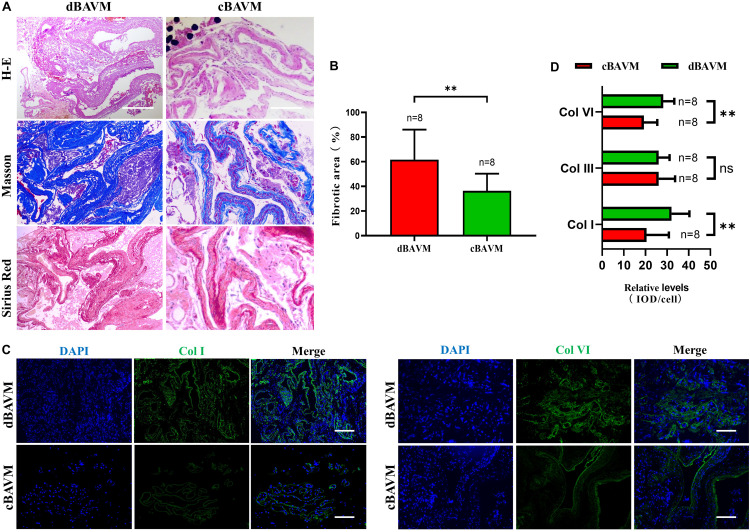
Upregulation of DCN promotes the overproduction of extracellular matrix in diffuse BAVMs. (A) Masson and Sirius red staining for collagen deposition in BAVM tissues. Fibronectin and collagen area indicated as blue. The scale bar corresponds to 200 μm. ∗∗P < 0.01. (B) The histograms showed the semiquantitative grading of fibrotic area in diffuse and compact BAVMs. (C) Immunofluorescence staining for Col I and Col VI in BAVM tissues. Several representative images of diffuse and compact BAVMs are shown. The scale bar corresponds to 200 μm. (D) The histograms showed the semiquantitative grading of Col I, Col III, and Col VI in diffuse and compact BAVMs. ∗∗P < 0.01; ns, P > 0.05.